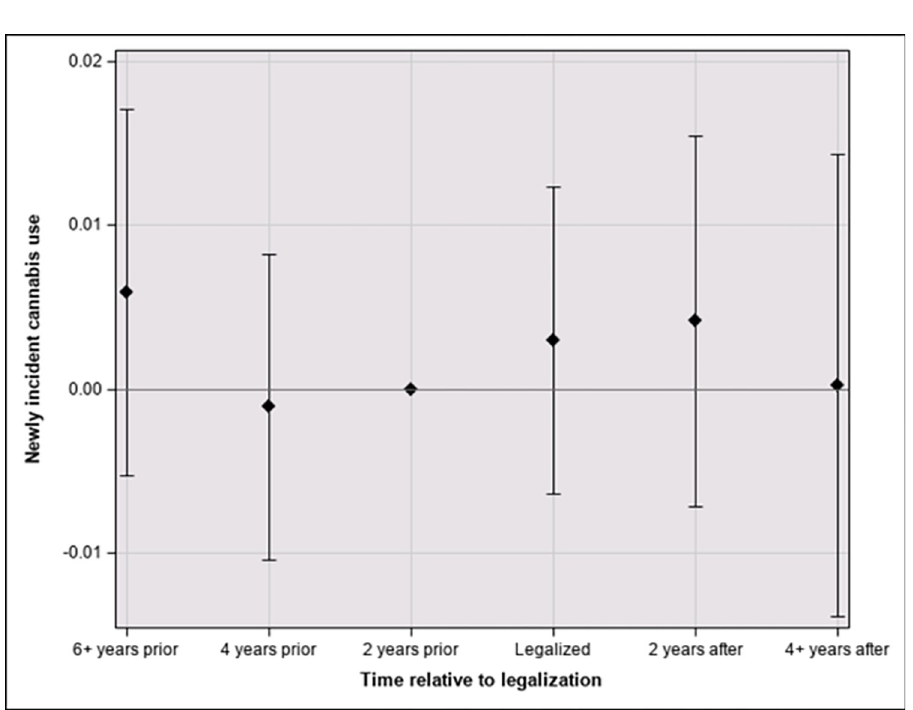
Fig 2. Effect of time since legalization on incidence in 12-to-20-age-group with 95% confidence intervals.